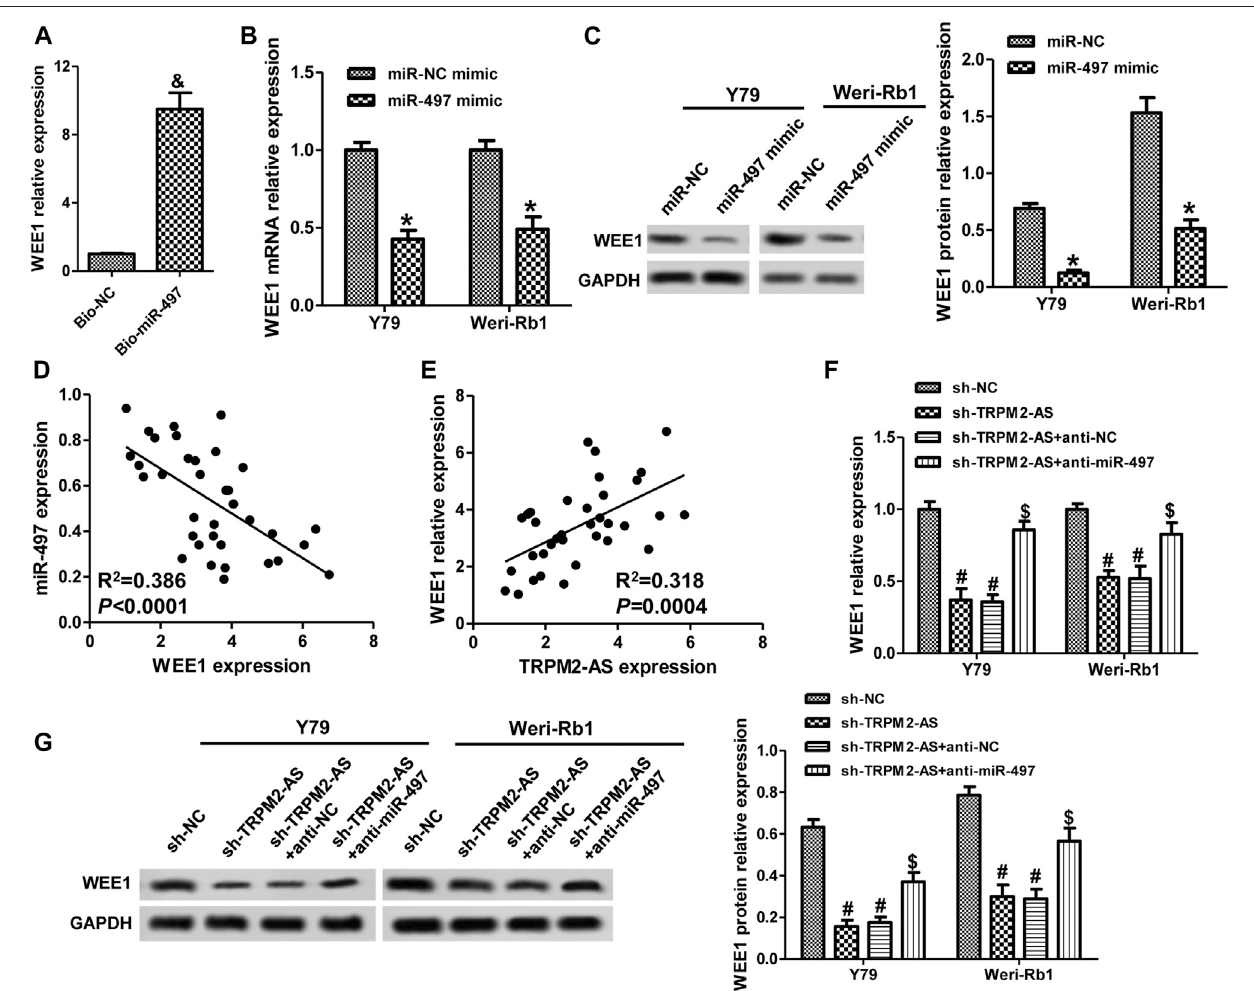
FIGURE6| TRPM2-ASmediatesWEE1expressionviaregulatingmiR-497inRBcelllines. (A) TheabundanceofWEE1inWeri-Rb1cellstransfectedwithBio-miR- 497 or Bio-NC. Y79 and Weri-Rb1 cells were transfected with miR-497 or control mimic, and the mRNA (B) and protein (C) levels of WEE1 were measured by real-time PCRandwesternblot,respectively. (D) TheconnectionbetweenWEE1andmiR-497expressionin35RBtissueswasanalyzedbyPearsoncorrelationanalysis. (E) The correlation between WEE1 and TRPM2-AS in 35 RB samples. (F) Y79 and Weri-Rb1 cells were transfected TRPM2-AS shRNA with or without miR-497 inhibitor, and WEE1 mRNA expression was detected by real-time PCR. (G) The protein levels of WEE1 were assayed by western blot. & p < 0.05 vs. the Bio-NC group; * p < 0.05 vs. the miR-NC mimic group; # p < 0.05 vs. the sh-NC group; $ p < 0.05 vs. the sh-TRPM2-AS group.